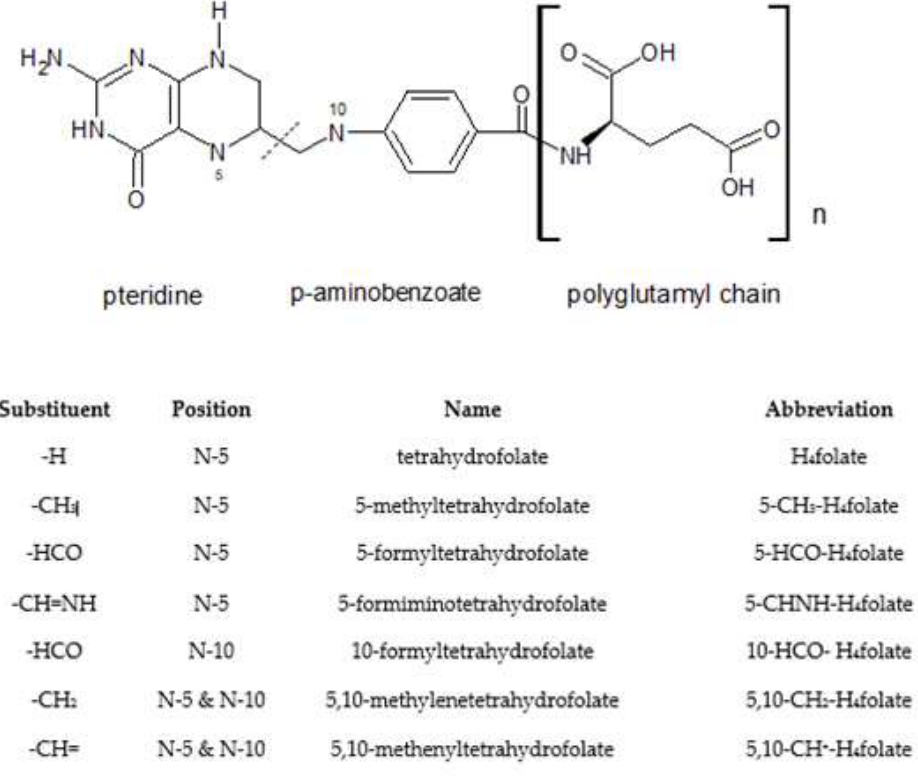
Figure 1. Structure of folic acid and polyglutamyltetrahydrofolates.